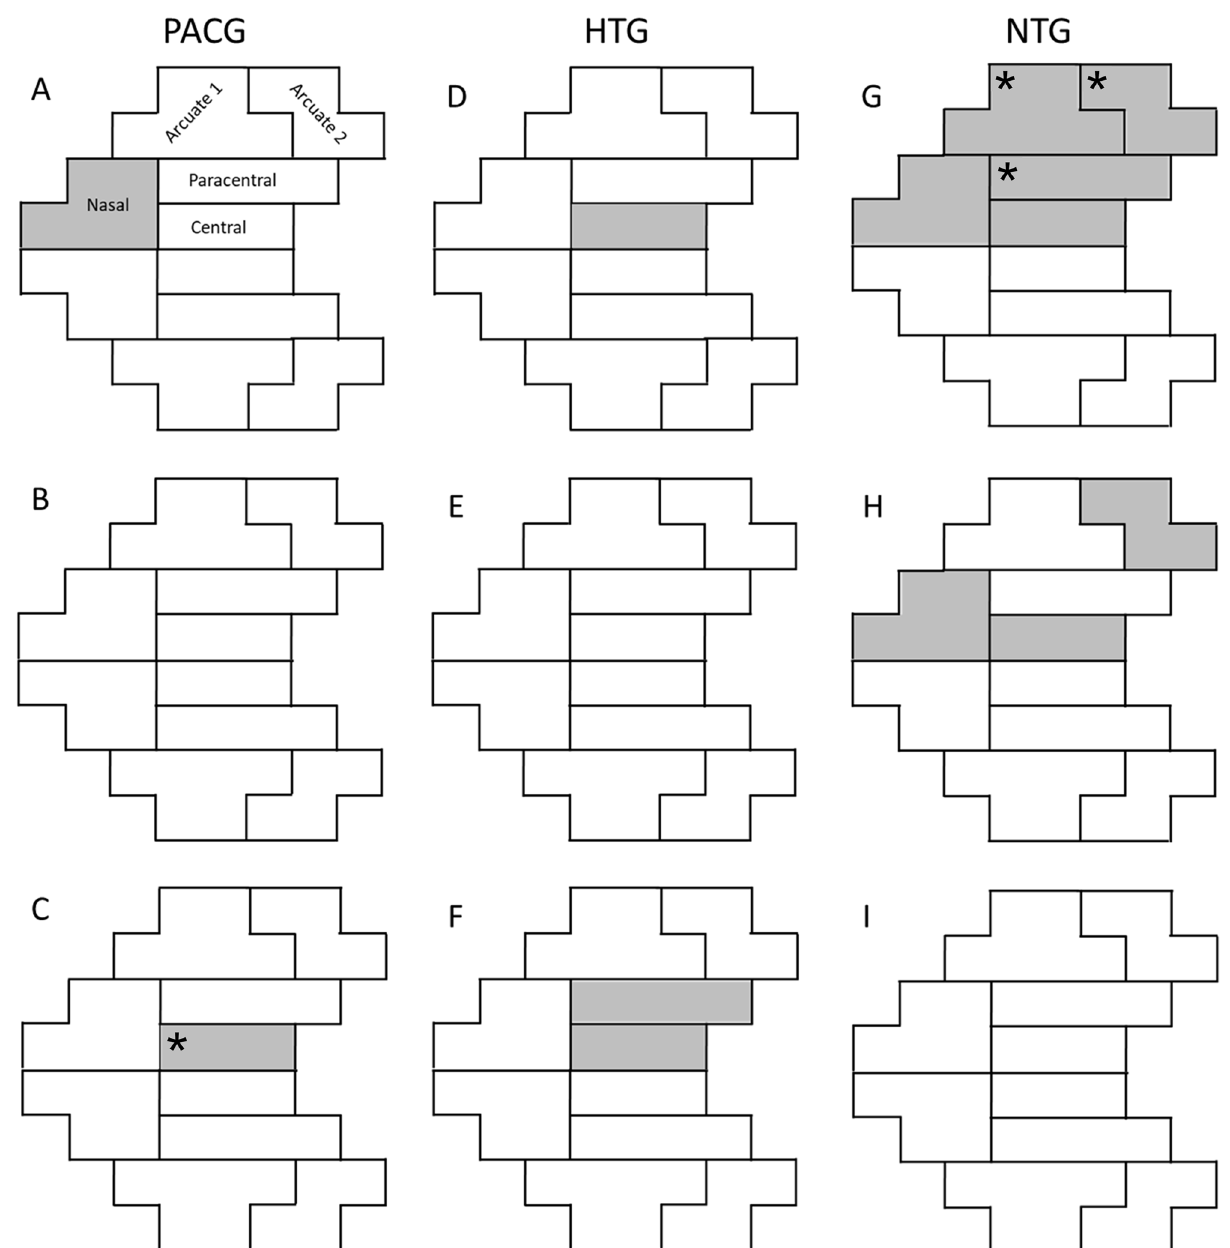
(A,D,G) represent early stages; (B,E,H) represent moderate stages, and (C,F,I) represent advanced stages. The shaded regions indicate significantly worse TD values than their inferior counterparts (P < 0.05) and asterisks indicate significant regions after Bonferoni correction. Image was generated using Microsoft PowerPoint software (Version 2016, Microsoft, Redmond,